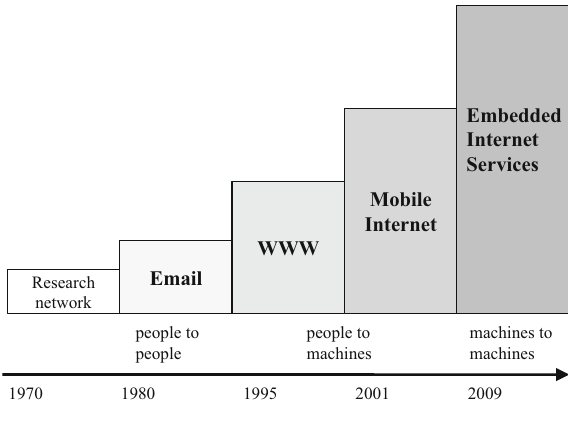
Fig. 2 Shifts in the use of the Web